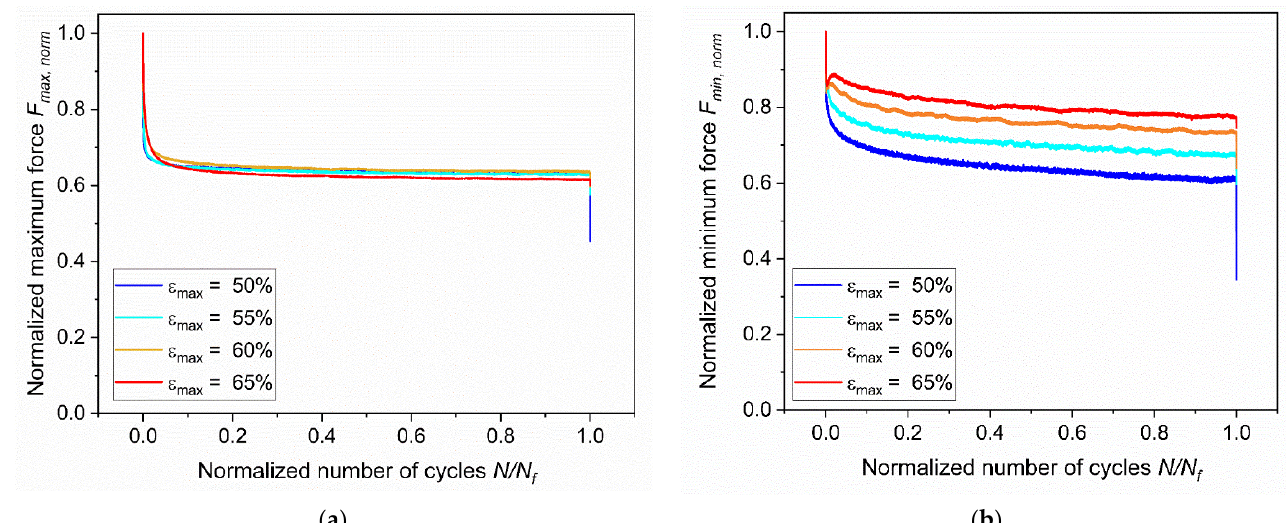
Figure 8. ( a ) Normalized maximum force at different strains against normalized number of cycles. ( b ) Normalized minimum force at different strains against the normalized number of cycles. The fatigue tests were implemented on axisymmetric dumbbell specimens of CB filled NBR at a frequency of 4 Hz and a load ratio R ε of 0.5.